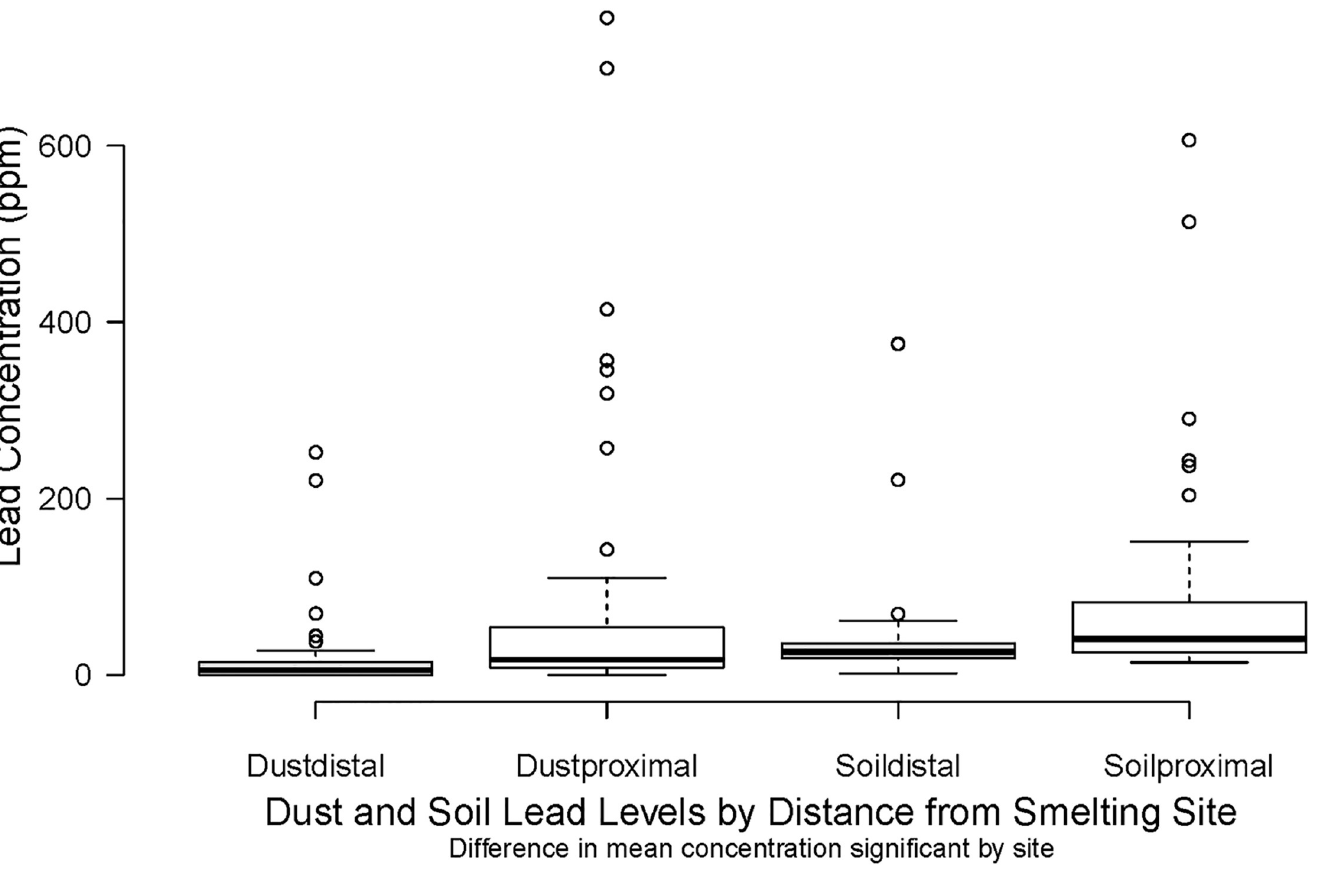
Fig 2. Dust and soil